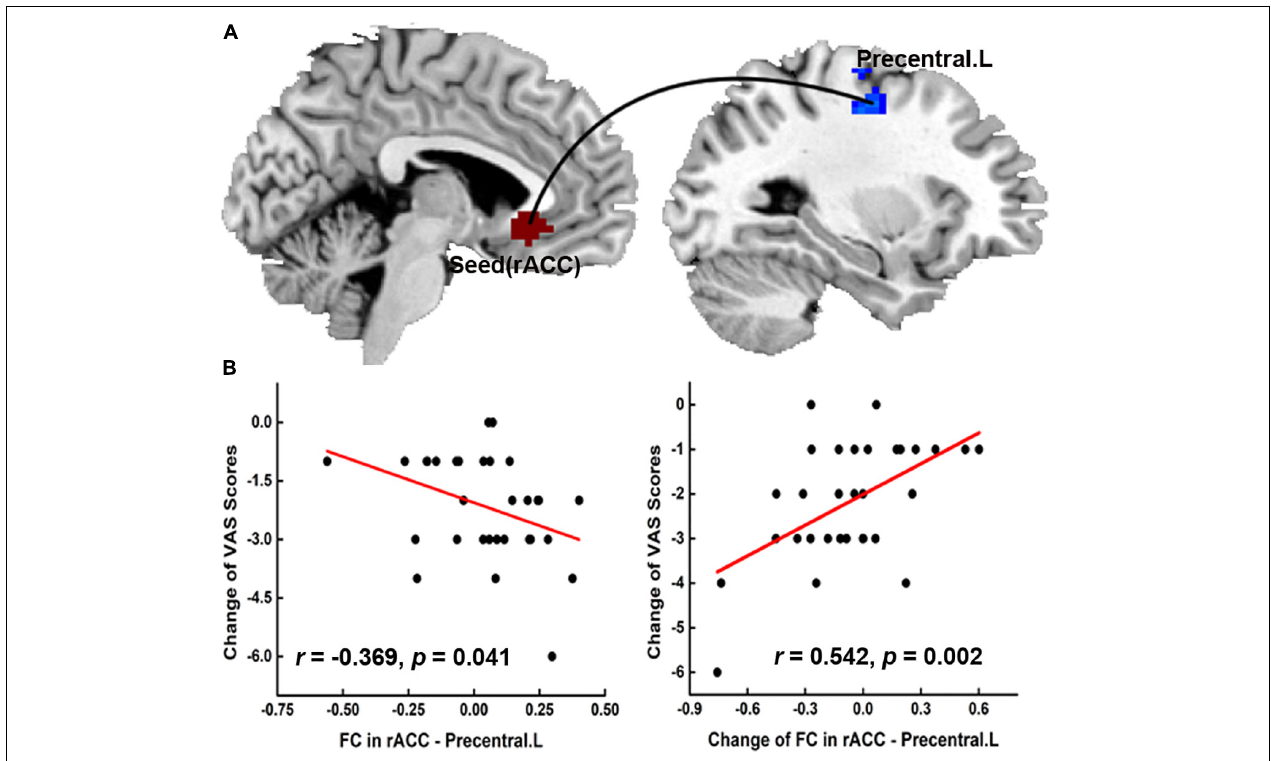
FIGURE 4 | The seed-based functional connectivity results and clinical significance. (A) The significant group difference FC change (post- vs. pre-) between RA and SA group was found in FC between rACC and left precentral gyrus. (B) The FC of rACC-Precentral.L in the baseline was negatively correlated with the short-time pain analgesia, while the change of FC in rACC-Precentral.L was positively correlated with the short-time pain analgesia in PDM patients after acupuncture treatment. FC, functional connectivity; rACC, rostral anterior cingulate cortex; VAS, visual analog